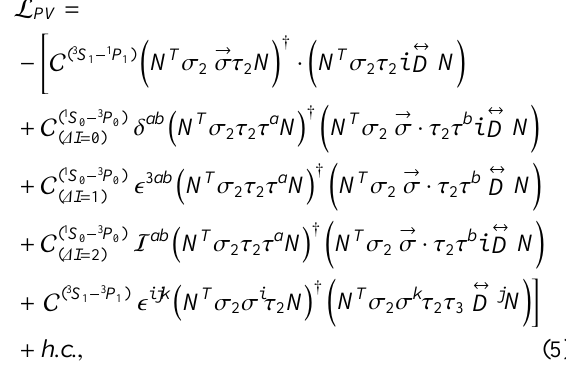
Fig. 4. Mixing of strong S wave operators. or triplet parameter.